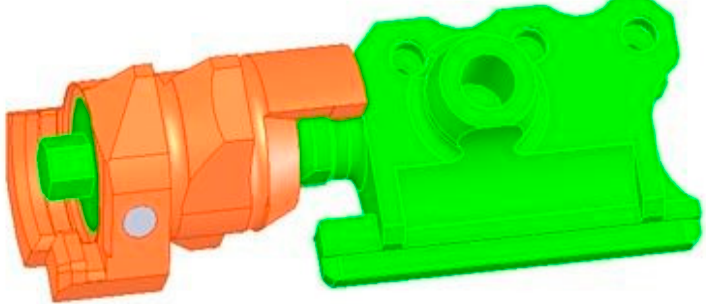
Figure 19. The recoil roller simulation with 0.1 mm clearance.